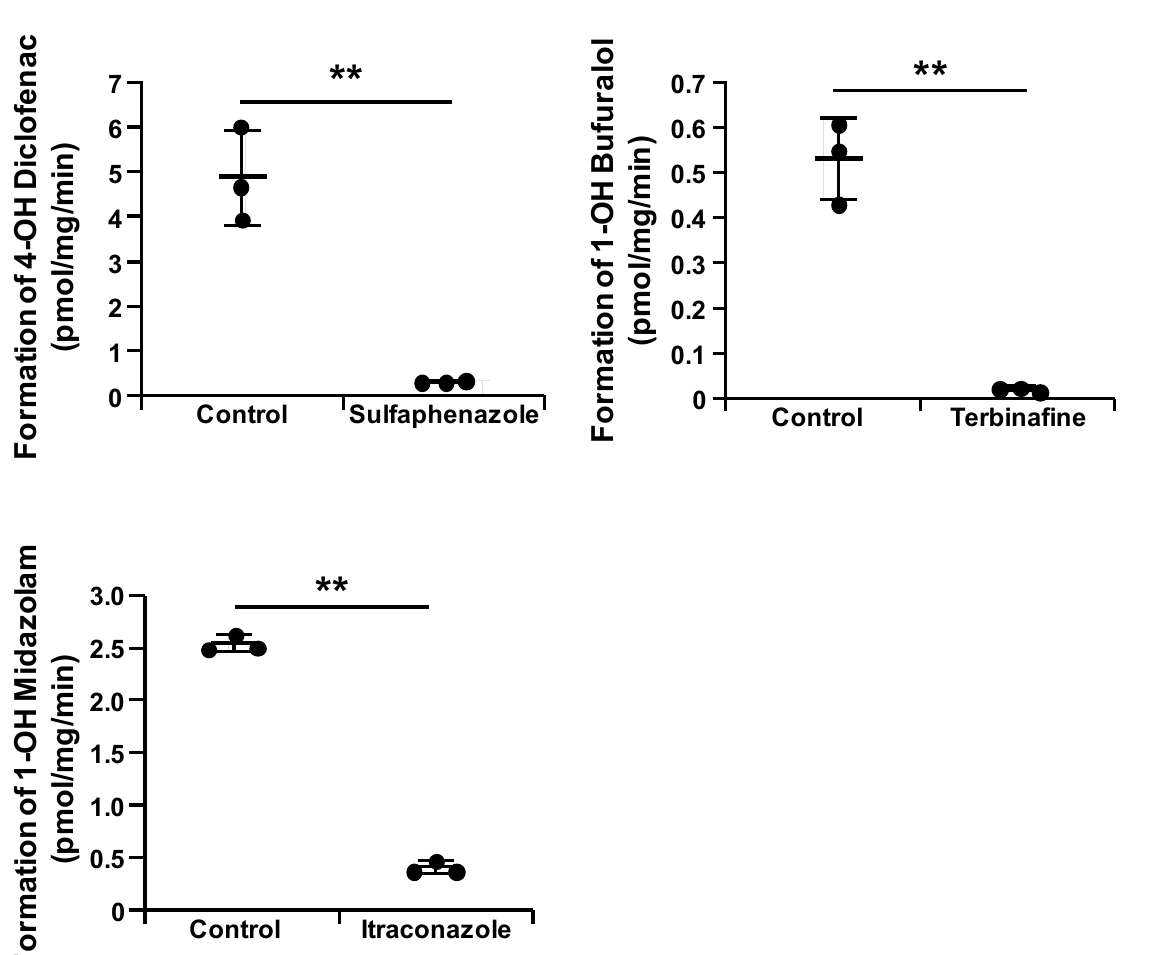
Figure 4. CYPs-UGT1A1 KI-HepG2 cells can be utilized in predicting drug-drug interactions. The CYP2C9, CYP2D6, and CYP3A4 activities in the 10 µ M sulfaphenazole (a CYP2C9 inhibitor), 10 µ M terbinafine (a CYP2D6 inhibitor), or 10 µ M itraconazole (a CYP3A4 inhibitor)-treated CYPs– UGT1A1 KI-HepG2 cells were evaluated by quantifying the metabolites of CYP substrates (10 µ M diclofenac, 1 µ M bufuralol, 10 µ M midazolam; these compounds are substrates for CYP2C9, 2D6, and 3A4, respectively). The quantity of metabolites (4 (cid:48) -hydroxy diclofenac, 1 (cid:48) -hydroxy bufuralol, and 1 (cid:48) -hydroxy midazolam; these compounds are metabolites for CYP2C9, 2D6, and 3A4, respectively) were measured by HPLC. Data represent the means ± SD ( n = 3, technical replicates). Statistical analyses were performed using the unpaired two-tailed Student’s t test (** p < 0.01). Many drugs are metabolized by multiple cytochrome P450s or in different ways by the same P450. We investigated the metabolism of propranolol in the CYPs–UGT1A1 KI- HepG2 cells. In the WT-HepG2 cells, the three main metabolites (4 (cid:48) -hydroxy propranolol, 5 (cid:48) -hydroxy propranolol, and desisopropylpropranolol) were undetectable, whereas they were present at detectable levels in the CYPs–UGT1A1 KI-HepG2 cells (Figure